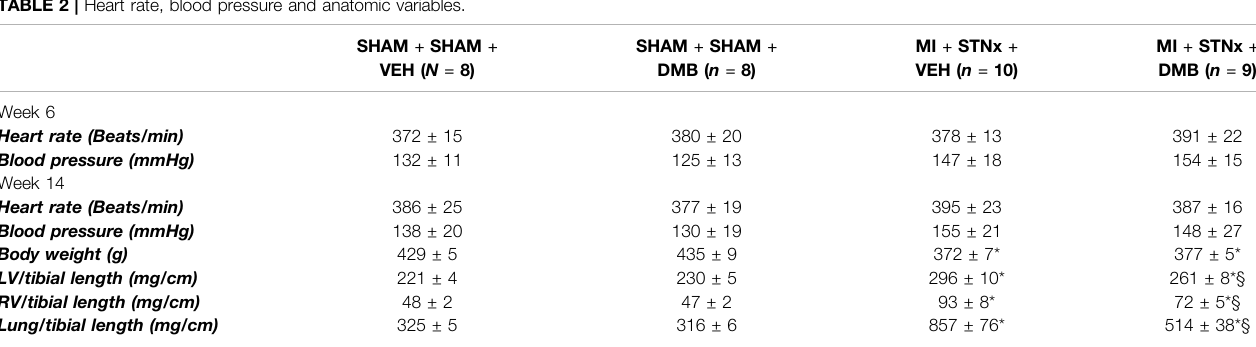
TABLE 2 | Heart rate, blood pressure and anatomic